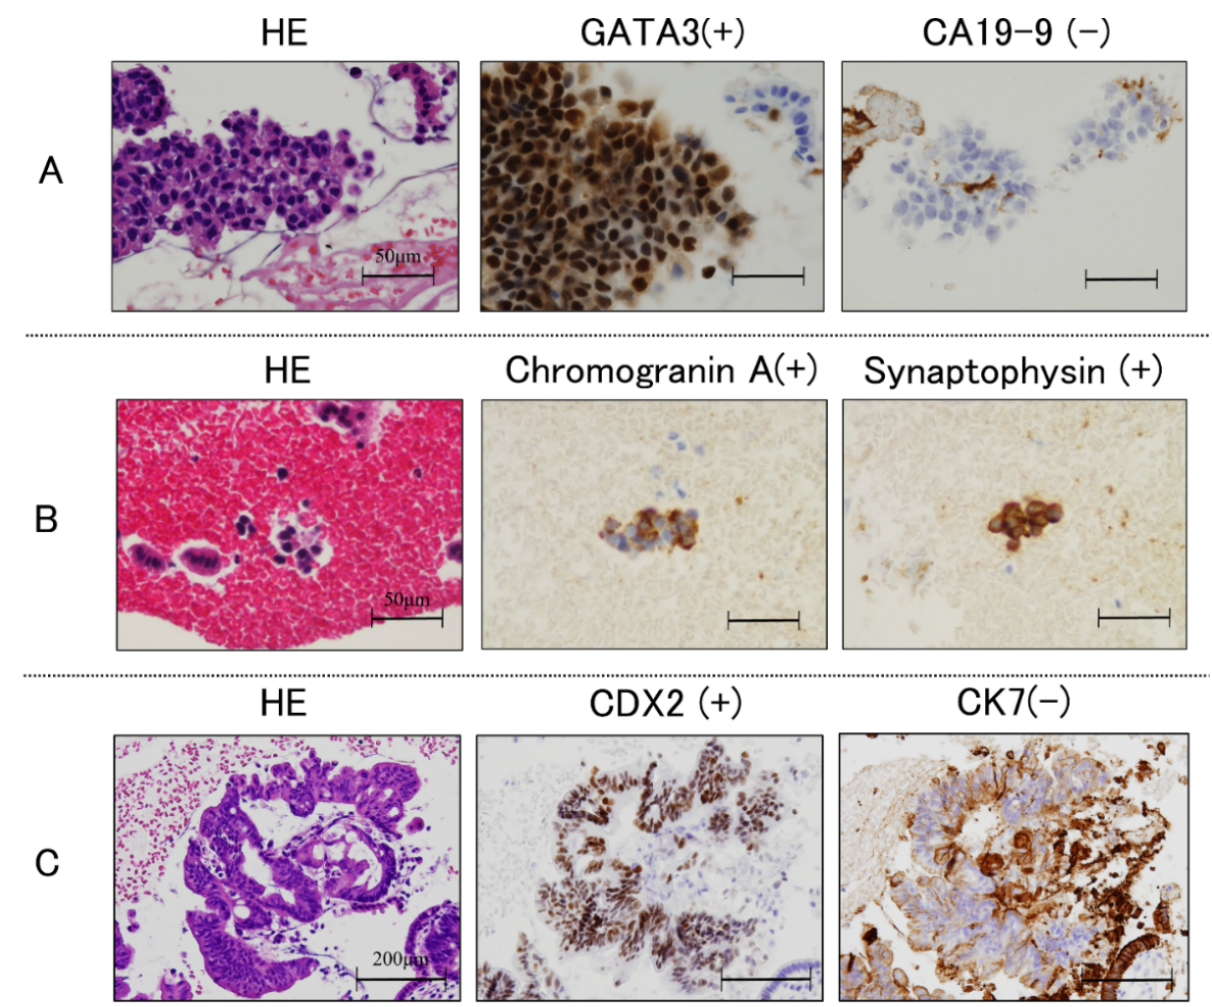
Figure 2. Histological findings. Immunohistochemical staining of cell block sections obtained using endoscopic scraper; ( A ): negative for cytokeratin 7 (CK 7), and positive for CK 20 and caudal-type homeobox 2 (CDX 2); ( B ): positive for CD56, chromogranin and synaptophysin; ( C ): positive for GATA3 and p40, and focally positive for CK20.